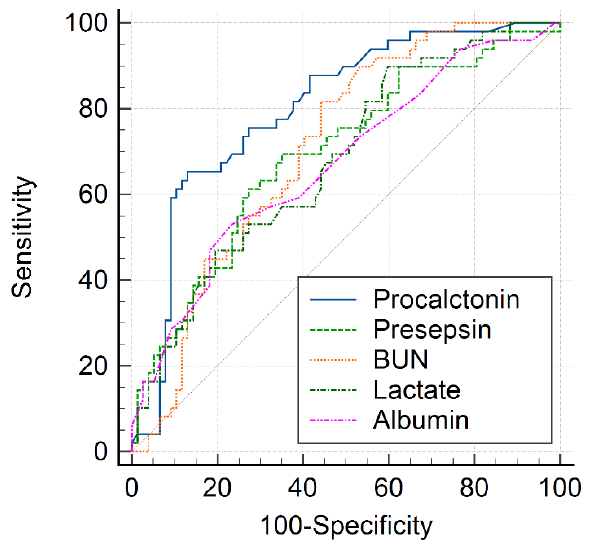
Figure 1. Receiver operating characteristic curves of laboratory biomarkers for acute kidney injury in patients with COVID-19.